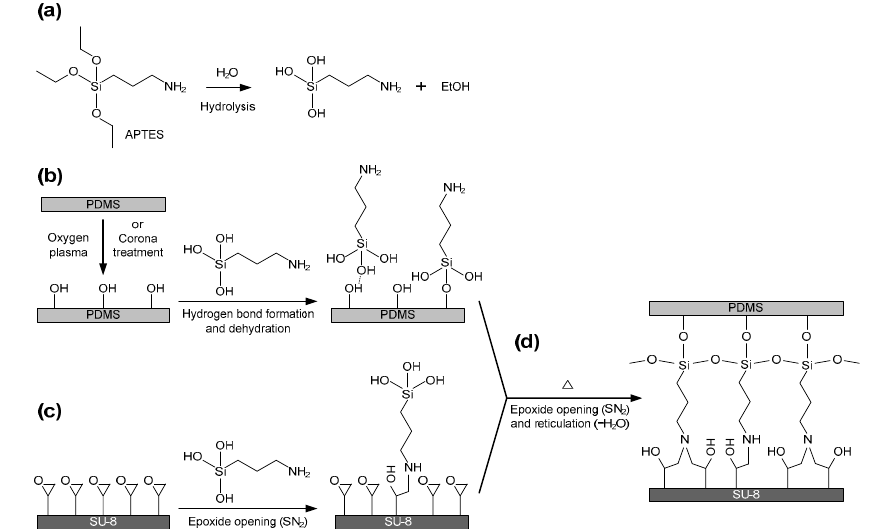
Figure 1. Surface modification and reaction in the poly(dimethylsiloxane) (PDMS)-SU-8 bonding process: ( a ) hydrolysis of APTES reagent in water; ( b ) surface reaction of plasma-activated PDMS in the aqueous (3-aminopropyl)triethoxysilane (APTES) solution. The hydrolysate of APTES molecules is coupled to the silanol groups on the PDMS surface; ( c ) surface reaction of SU-8 in the aqueous APTES solution. The amino groups of APTES molecules react with the epoxy groups on the SU-8 surface (SN 2 reaction); ( d ) further epoxide opening reaction (SN 2 ) and condensation (reticulation, –Si–O–Si– formation) occurred at the sample interfaces when the APTES-functionalized PDMS and SU-8 were contacted and heated.